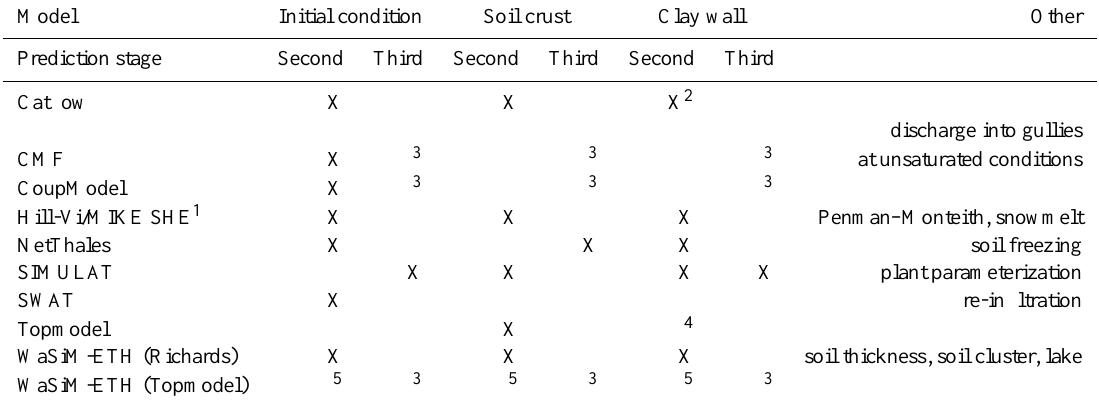
Table 3. Major modifications in the conceptualization of catchment processes and components between the first, second and third prediction. Model